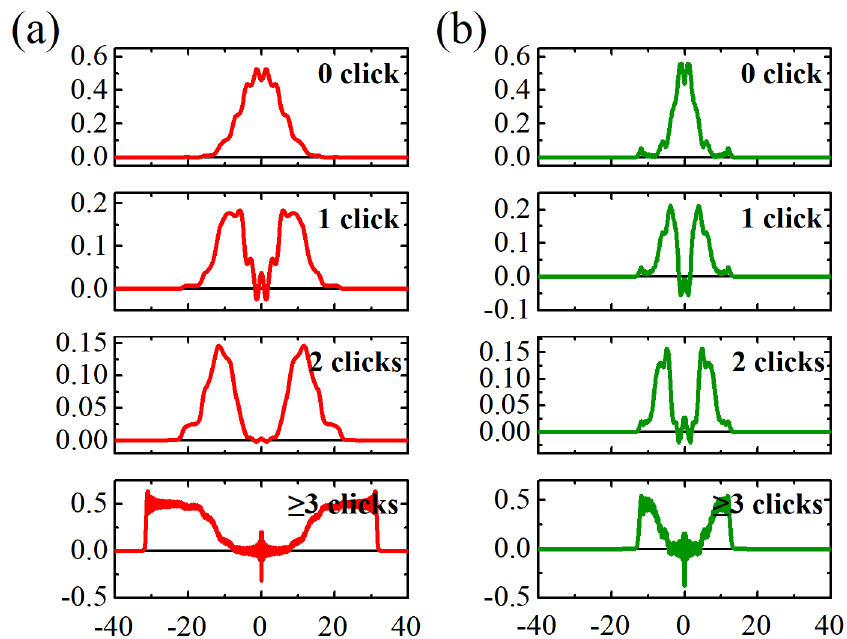
Figure 6. Cross section of the Wigner function for MPPC for 0 to ≥ 3 clicks outcomes at ( a ) 791 nm (red); ( b ) 523 nm (green). The solid lines provide the experimental Wigner function.